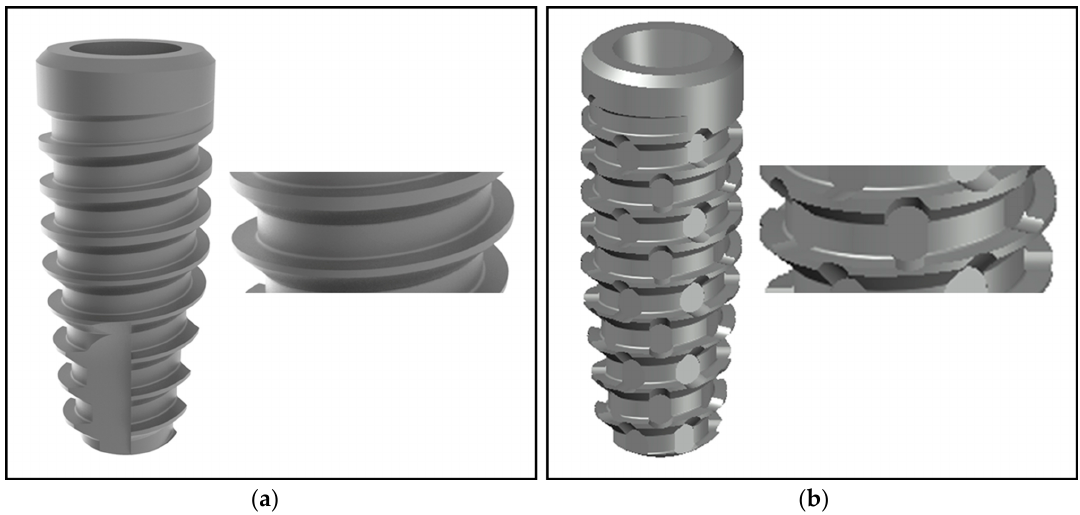
Figure 2. Representative image of the implants and thread closed: ( a ) Traditional conical implant macrogeometry and ( b ) new conical implant macrogeometry.